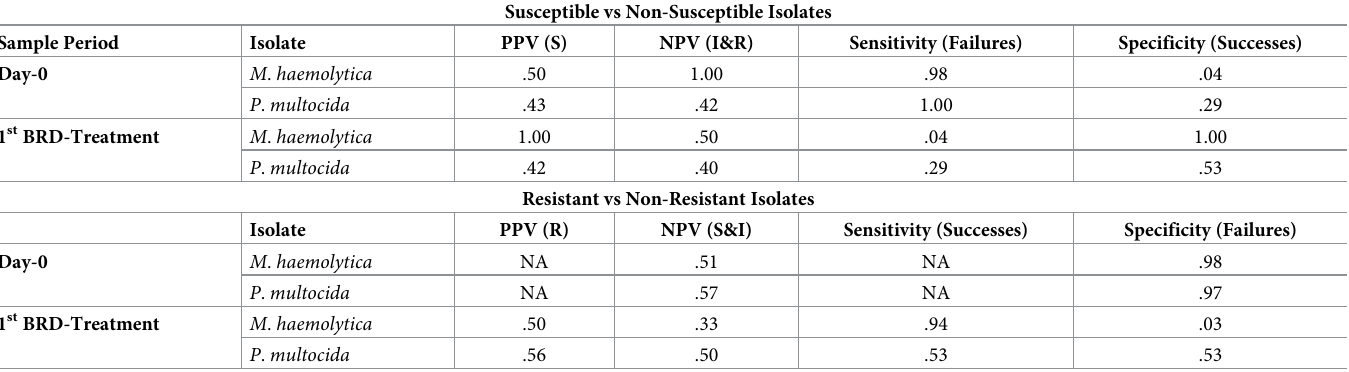
Table 5. Se, Sp, PPV, and NPV of tulathrymycin mic classification for M . haemolytica and P . multocida isolates collected from DNS samples from high-risk feeder heifers.